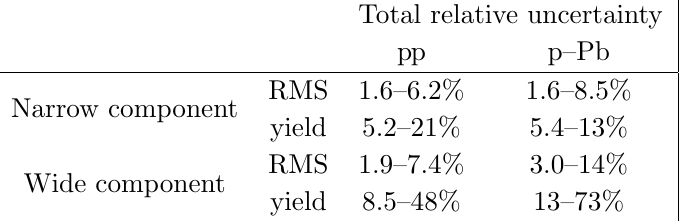
dependence of the studied observables k